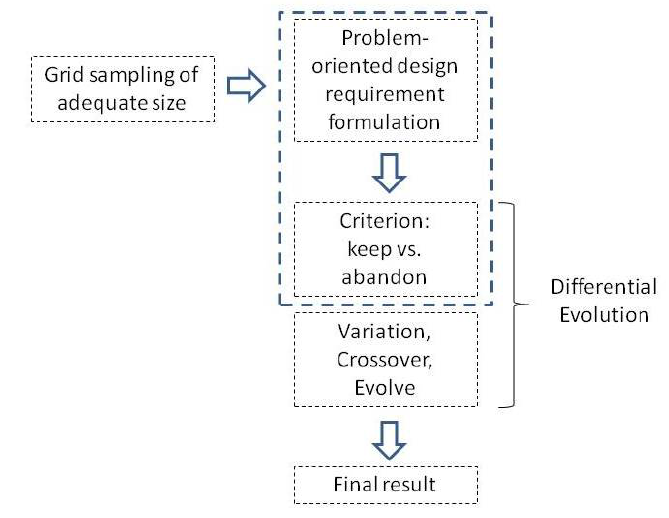
Figure 8. An improved optimization process with the new formulation of design requirement applied in the